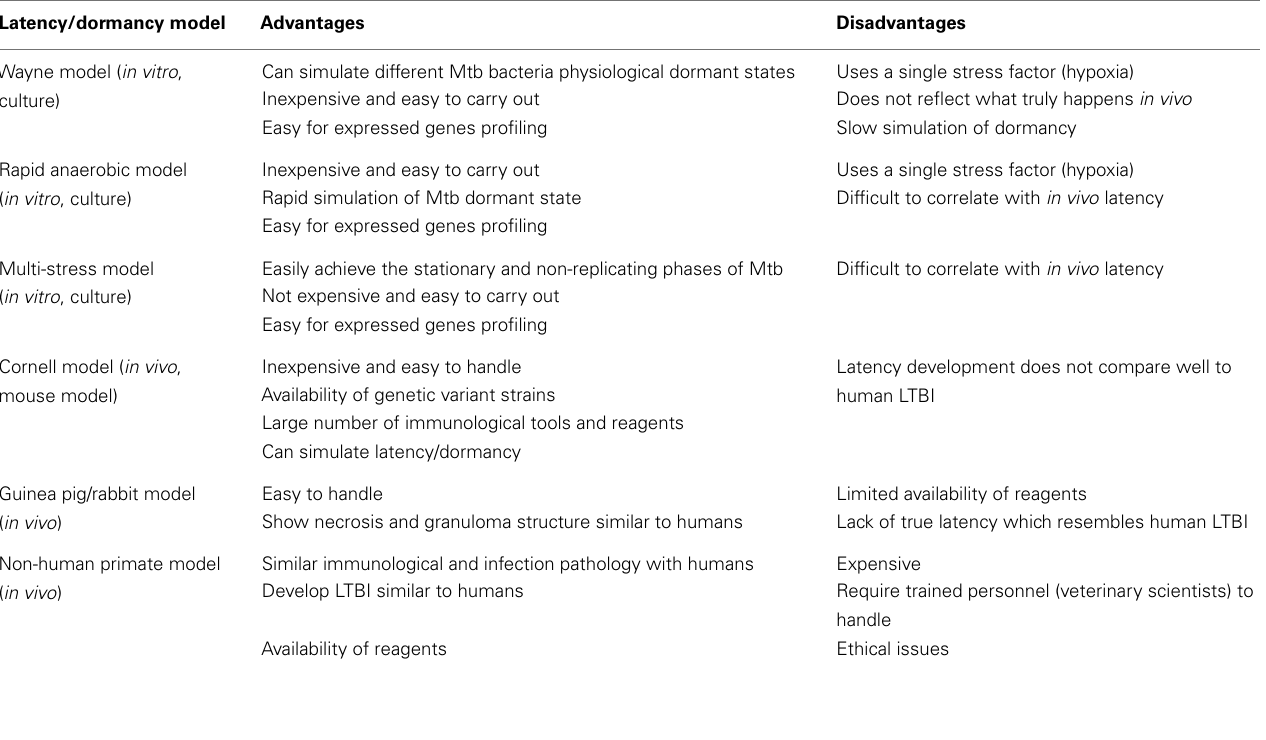
Table 2 | Latency/dormancy in vitro and in vivo